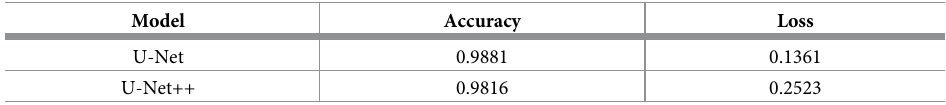
Table 5. Performance comparison between U-Net and U-Net++